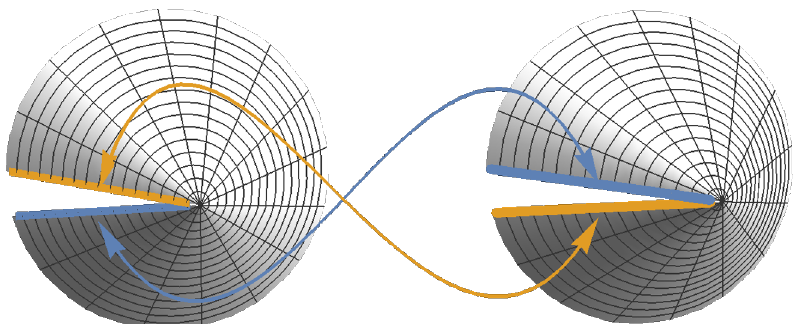
Figure 16. A sketch of the n = 2 replica wormhole geometry near the splitting surface γ , which lies at the tip of the cones. Comparing to 15(b), one cone corresponds to the top two spacetimes (one ‘ket’ and one ‘bra’) and the other to the bottom two, identified along Σ ext , leaving a cut in the cone along I . The two cones are joined along I with a swap (or more generally, a cyclic permutation) as indicated by the colours and arrows. The conical defect in each replica is required for the resulting replica wormhole spacetime to be smooth at γ